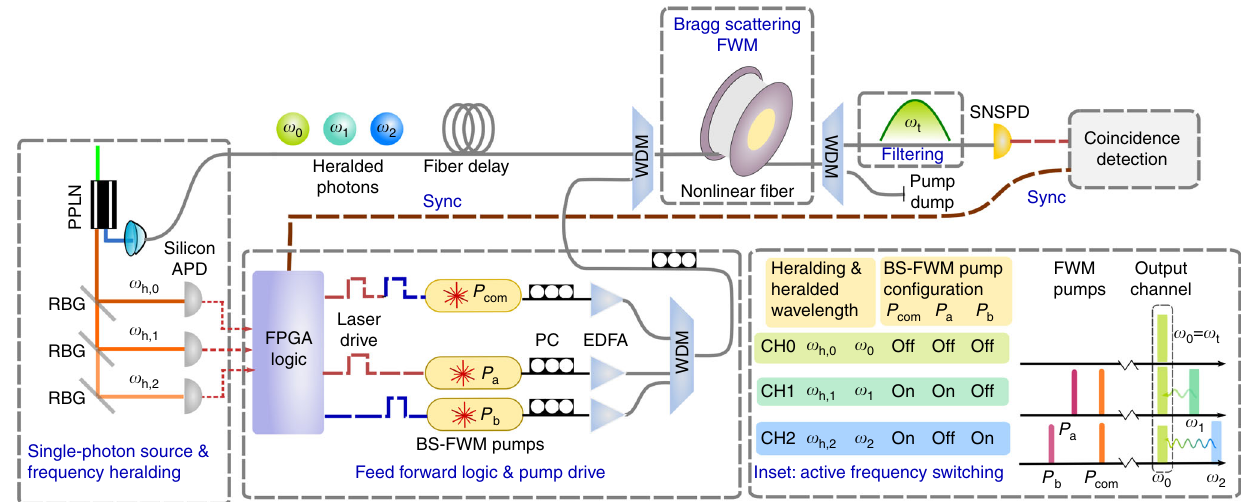
Fig. 3 Experimental setup for multiplexing of three frequency modes. PPLN periodically poled lithium niobate, RBG re fl ecting Bragg grating, FPGA fi eld programmable gate array, PC polarization control, EDFA erbium-doped fi ber ampli fi er, WDM wavelength division multiplexer, BS-FWM Bragg scattering four-wave mixing, SNSPD superconducting nanowire single-photon detector, APD avalanche single-photon detector. A PPLN crystal is pumped with a CW laser at 543 nm, generating photon pairs at 940 nm (heralding photons) and 1280 nm (heralded photons). The heralding photons are fi ltered into three channels { ω h,0 , ω h,1 , ω h,2 } with 100 GHz bandwidth, with corresponding heralded signal photons as { ω 0 , ω 1 , ω 2 }. An FPGA is used to process this